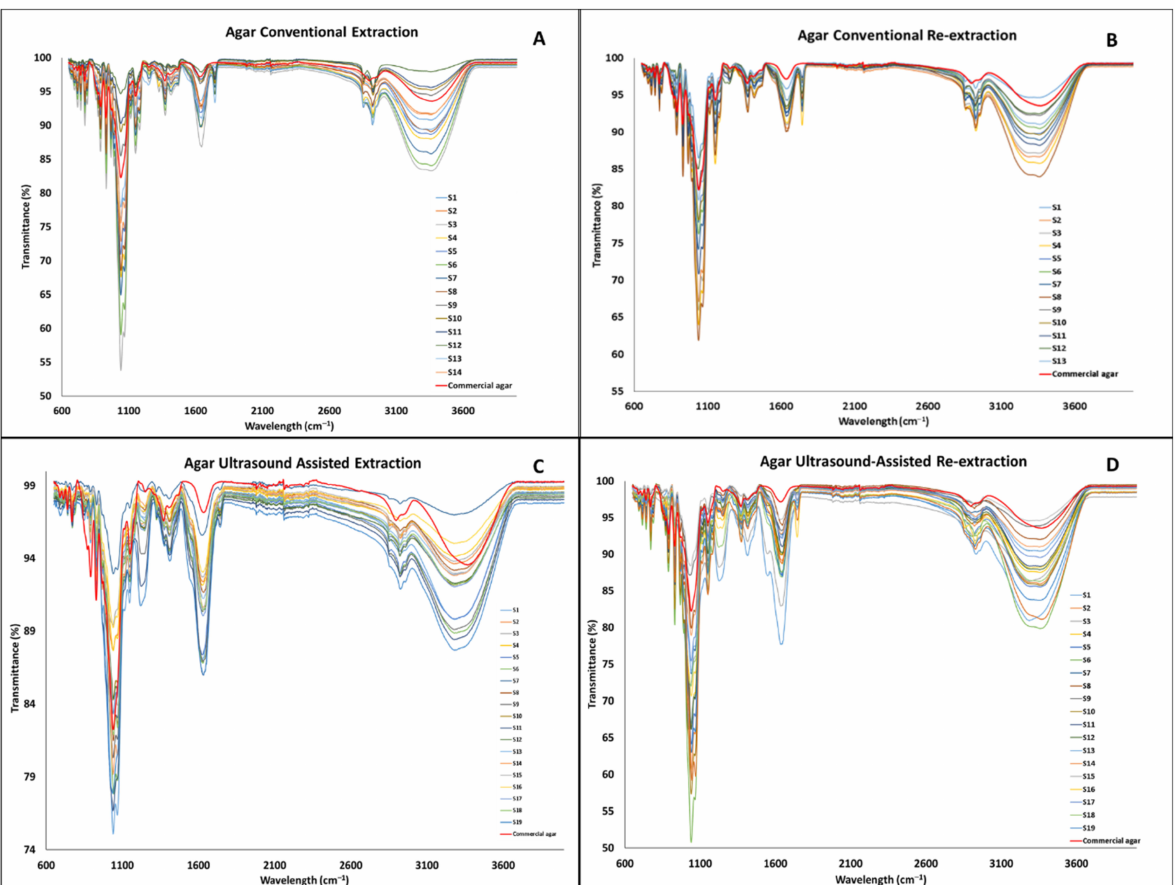
Figure 5. FT-IR spectra of the agar extracted by different methods (( A ) agar conventional extraction, ( B ) agar conventional re-extraction, ( C ) agar ultrasound-assisted extraction, ( D ) agar ultrasound- assisted